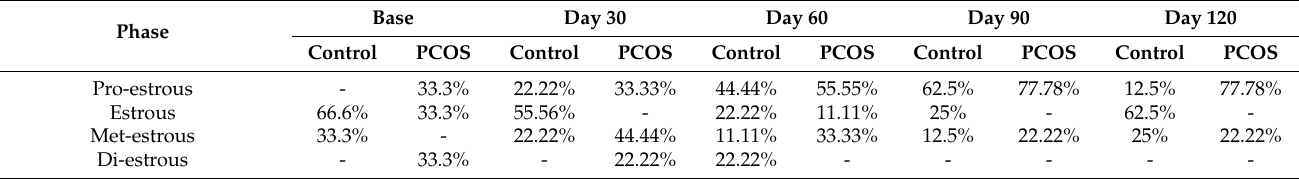
Table 1. Distribution of estrus cycle phases in the animals at the beginning of the experiment (Base), and on Day 30, 60, 90, and 120. The percentage of the rats in each phase was calculated based on the microscopic picture of the vaginal smears.